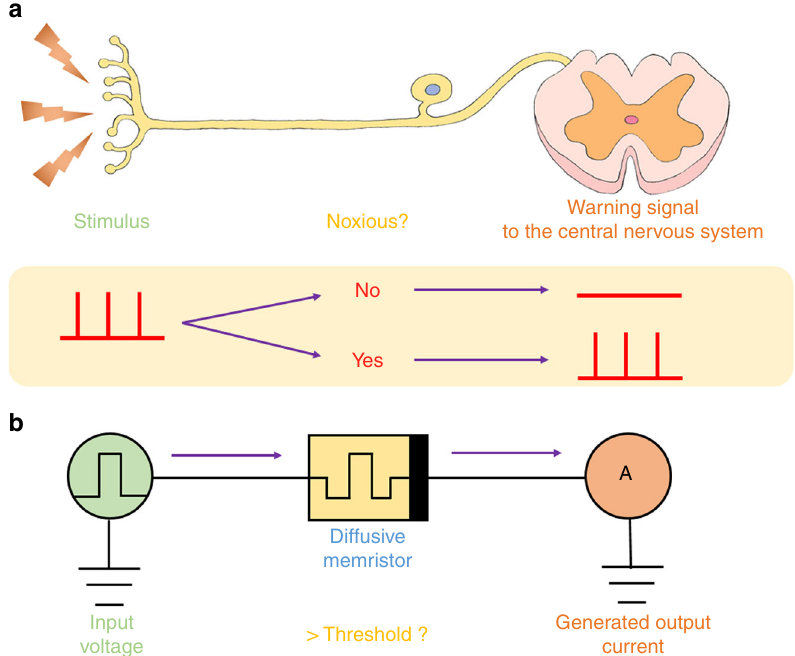
Fig. 1 One to one correspondence of the nociceptor system in the human body and an arti fi cial nociceptor circuit consisting of a diffusive memristor (threshold switch). a When a noxious stimulus is received from a free nerve ending, the nociceptor compares the amplitude of the signal with a threshold value and decides whether an action potential should be generated and sent to the brain via the spinal cord (central nervous system). b An electrical pulse applied on the device emulates the external stimulus. When the pulse amplitude is higher than the threshold voltage of the diffusive memristor, the device is turned ON, and current pulses are generated